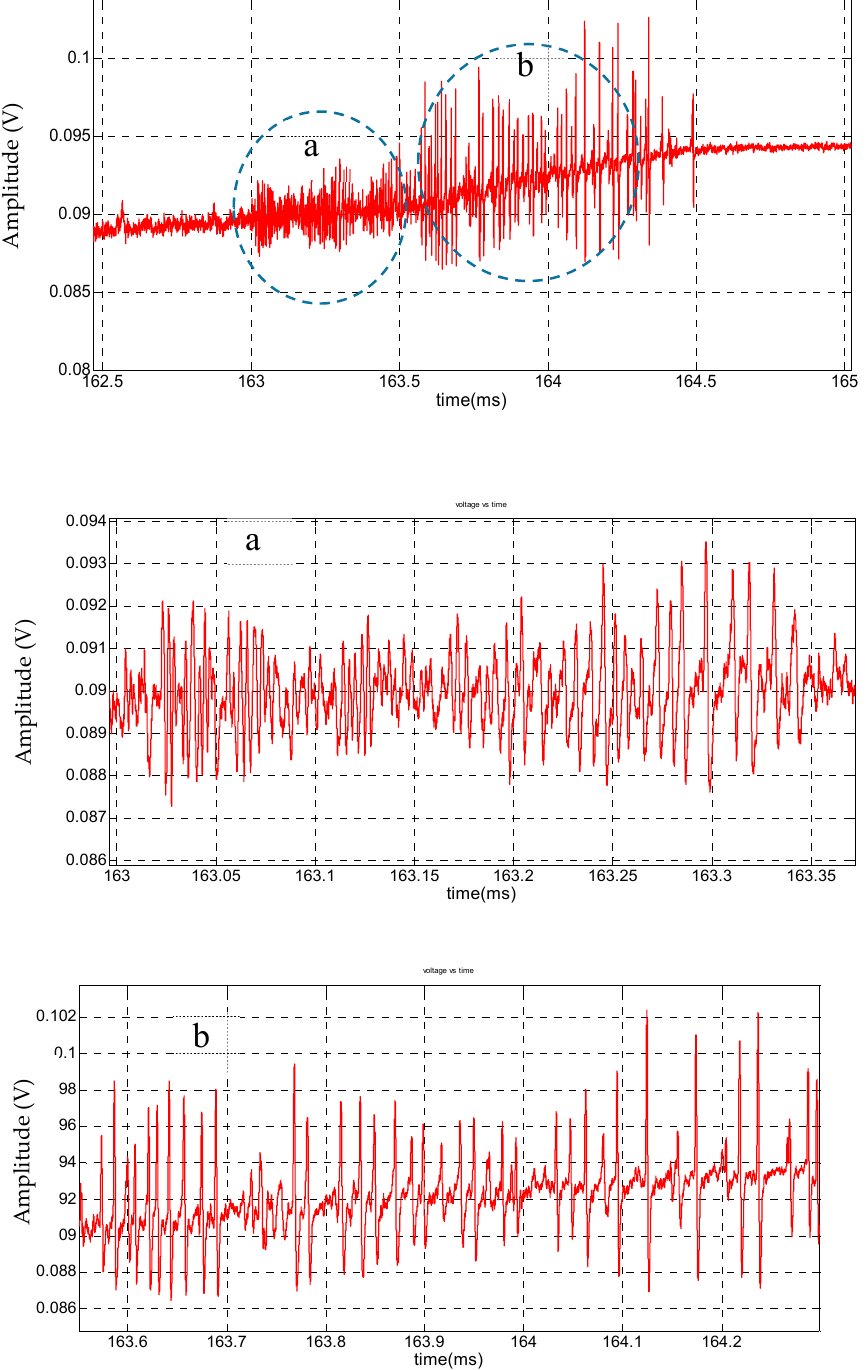
Figure 7. K-change starting with a chaotic pulse train (or somewhere between a chaotic and regular train) and ending with a regular pulse train (circled in dotted blue lines). Figures ( a , b ) shows the expanded view of chaotic and regular pulse components. Data were recorded on 4/5/2013 20:06:00. UTC.